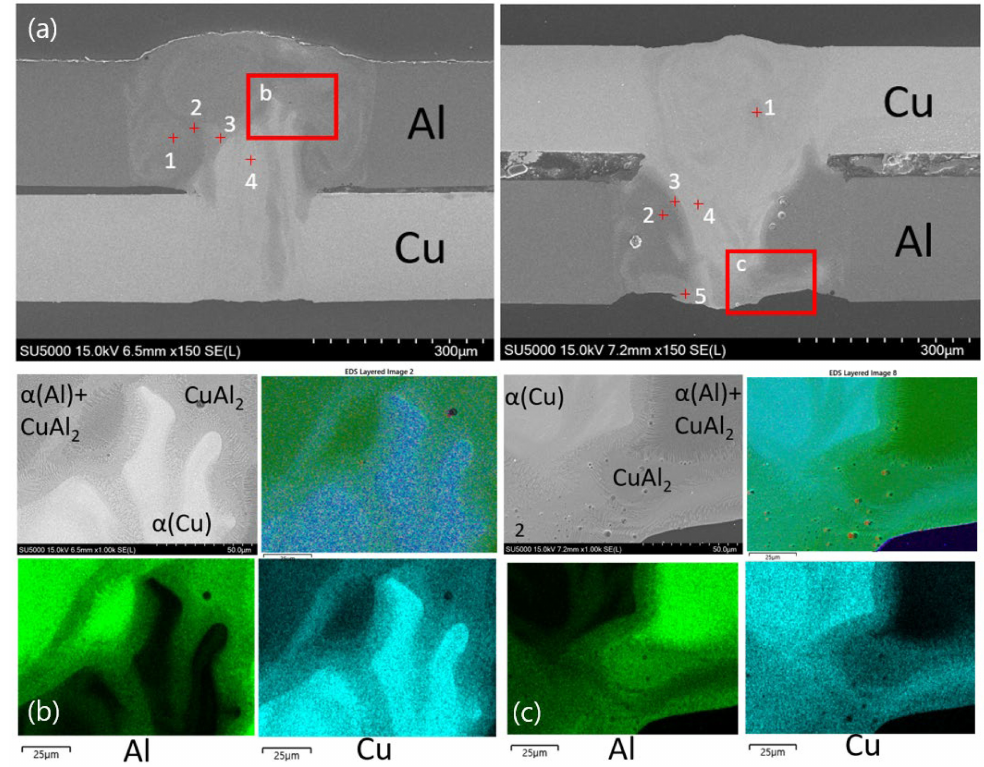
Figure 6. ( a ) Scanning electron microscopy images of the welded specimens. ( b , c ) EDS mapping images showing the distribution of Al and Cu to observe phase formation at a welding speed of 400 mm/s with: ( b ) Al as the upper layer, and ( c ) Cu as the upper